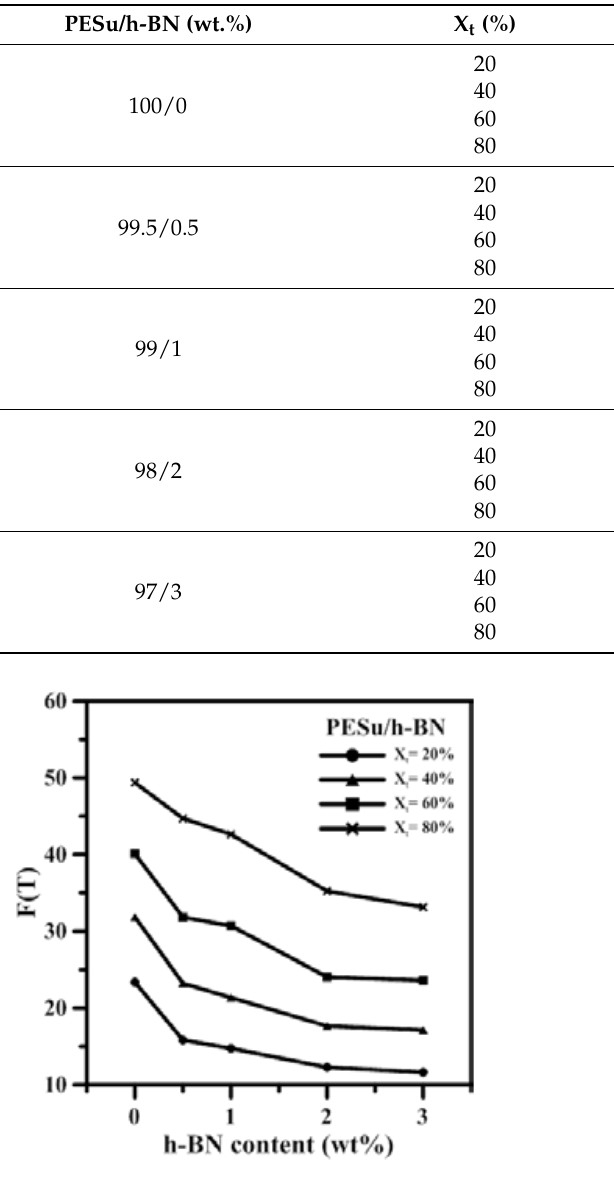
Table 2. Non-isothermal crystallization parameters calculated by the Mo model for various PESu/h- BN composites.